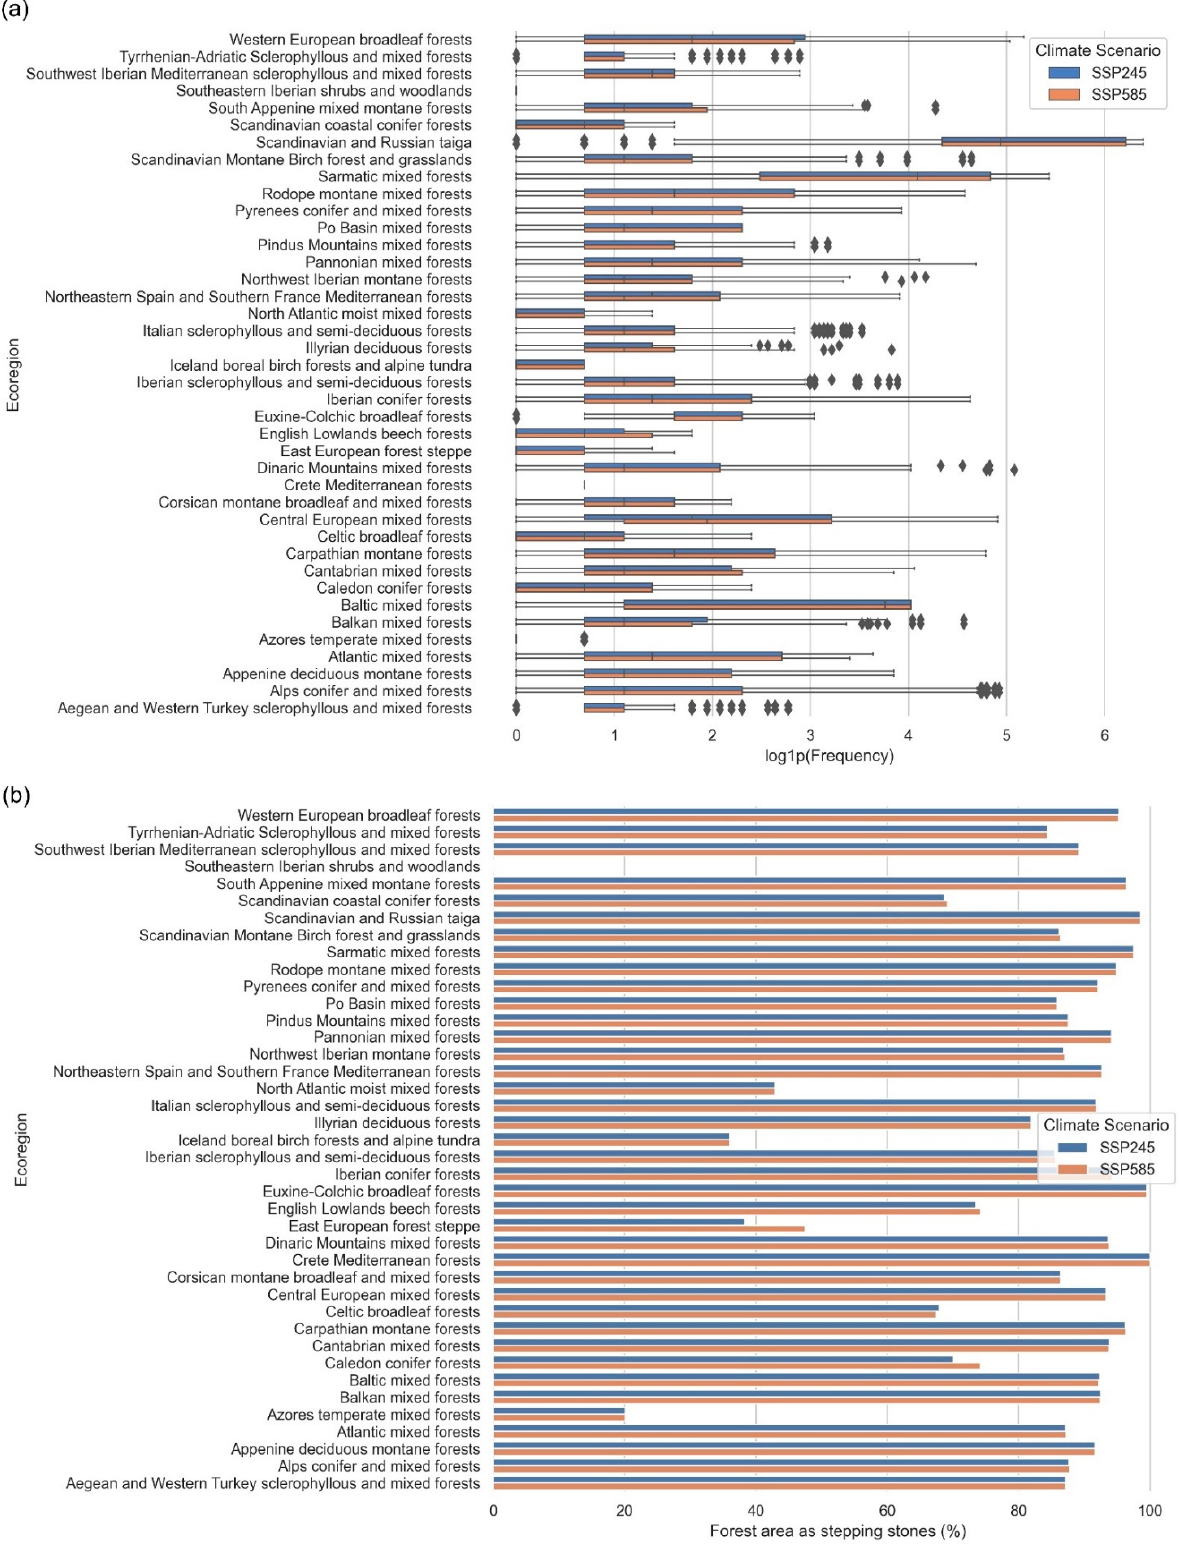
Figure 5. Forested areas as stepping stones, summarised by forest-dominated ecoregions: ( a ) the potential (frequency) of forested areas to serve as stepping stones for range shifts; ( b ) proportion of the total forested area that could serve as a stepping stone.